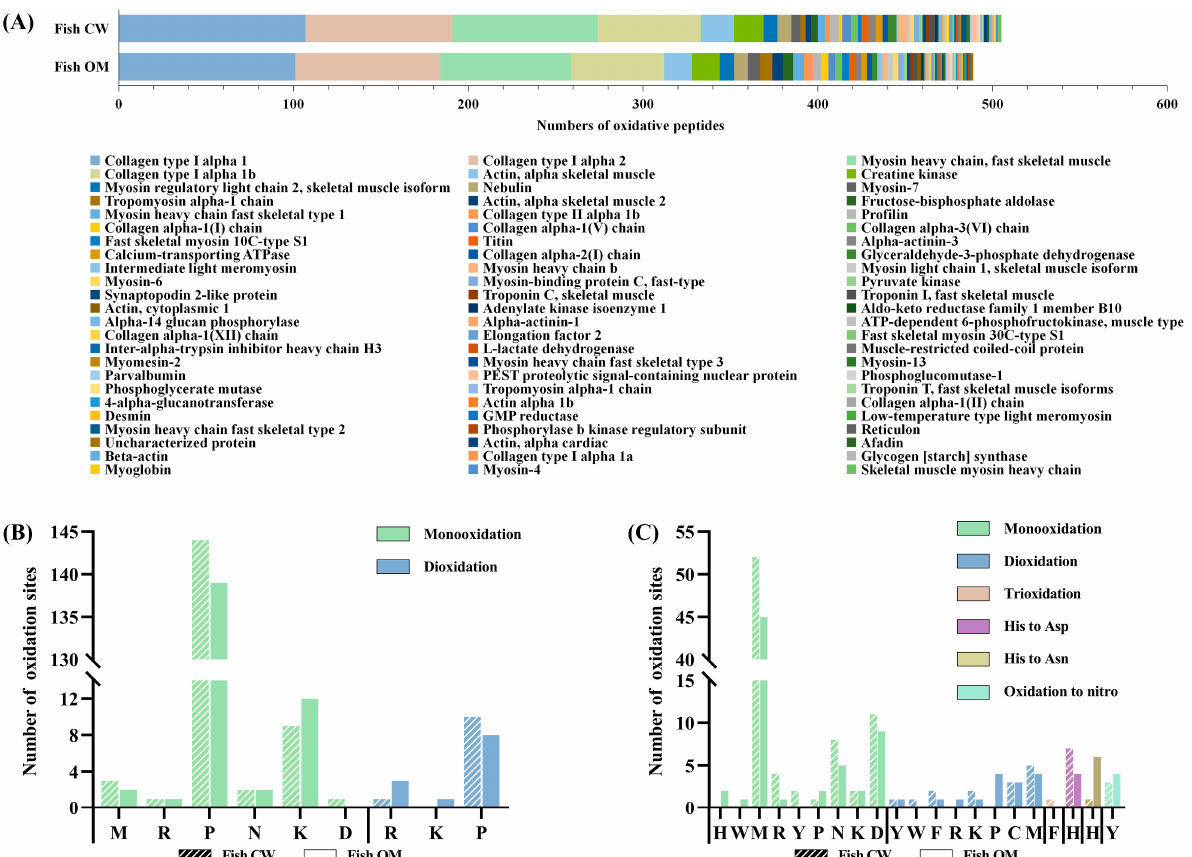
Figure 5. The number of oxidative peptides and the protein which they derived from ( A ); the type and the number of oxidative modifications in collagen type I alpha 2 ( B ); the type and the number of oxidative modifications in myosin, taking myosin heavy chain, fast skeletal muscle ( C ); CW: conventional water-washing; OM: ozone-microbubbles-washing. M: Methionine; D: Aspartic Acid; P: Proline; N: Asparagine; Y: Tyrosine; K: Lysine; C: Cysteine; H: Histidine; W: Tryptophan; R: Arginine; F: Phenylalanine. The protein name was according to the Uniprot database.